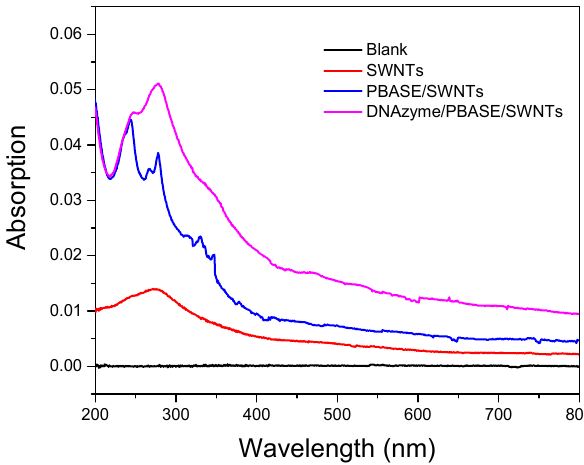
Figure 4. UV–VIS absorption spectra of quartz substrate functionalized with SWNTs, PBASE, and DNAzyme.